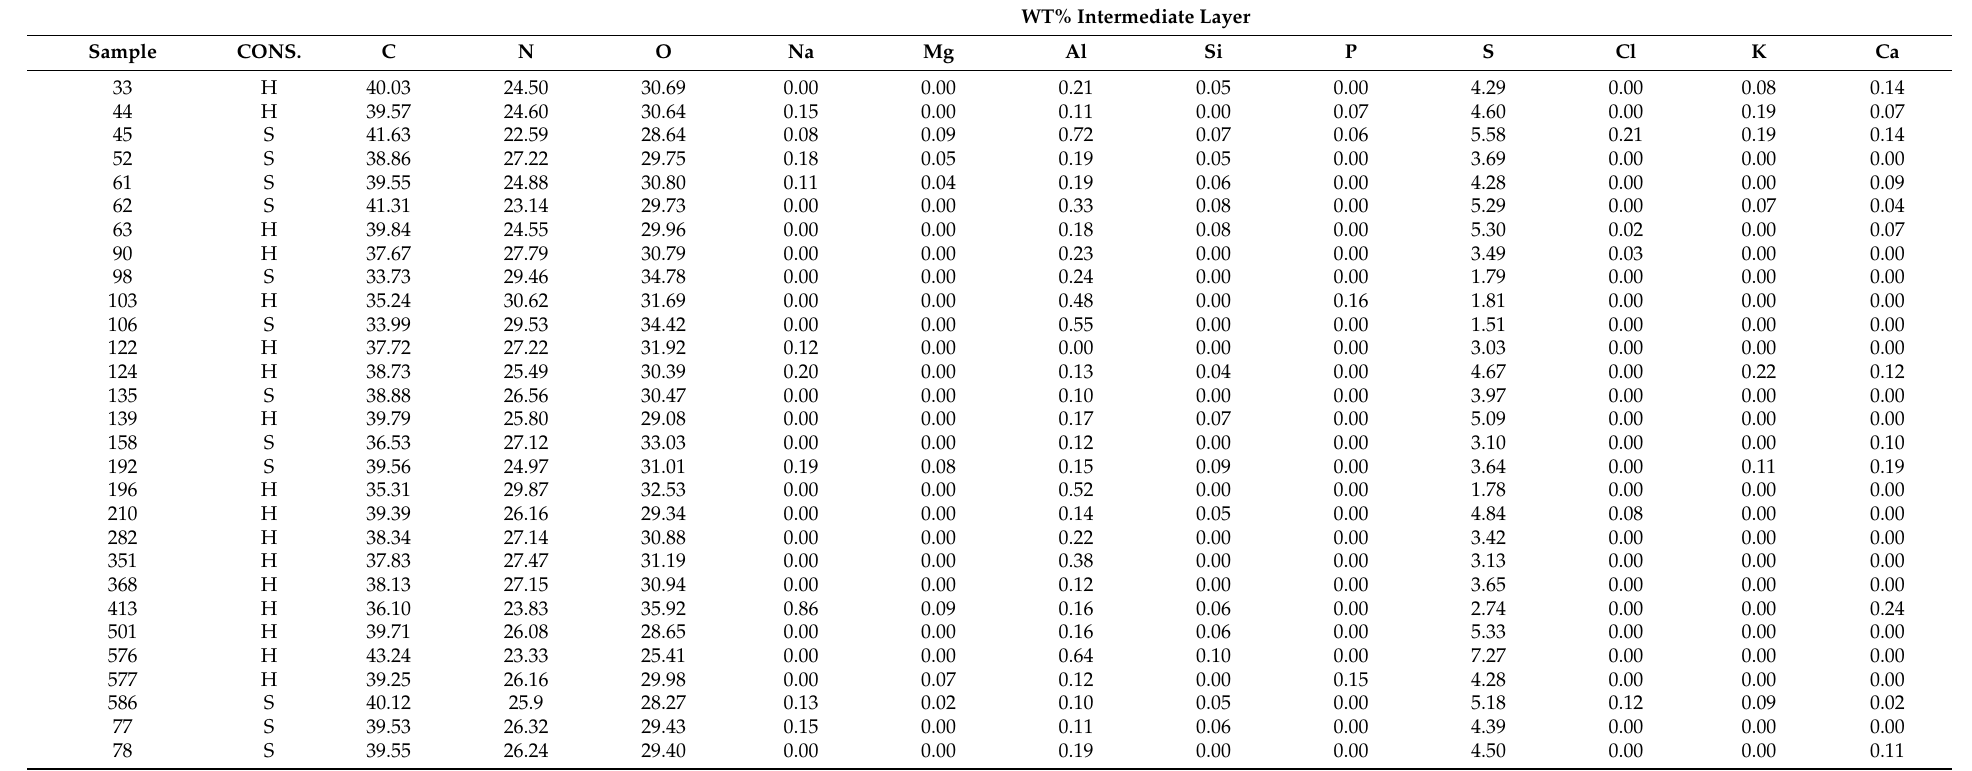
Table 3. WT% values of elements in the intermediate layer. WT%, weight percentage; CONS, consistency; C, carbon; N, nitrogen; O, oxygen; Na, sodium; Mg, magnesium; Al, aluminium; Si, silicon; P, phosphorus; S, sulphur; Cl, chloride; K, potassium; Ca, calcium; H, hard; S, soft; SD, standard deviation. WT% Intermediate